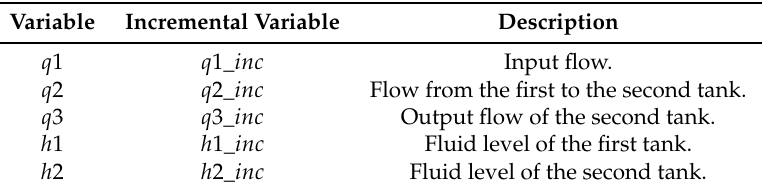
Table A2. Variables of the mathematical model (nonlinear and linear).